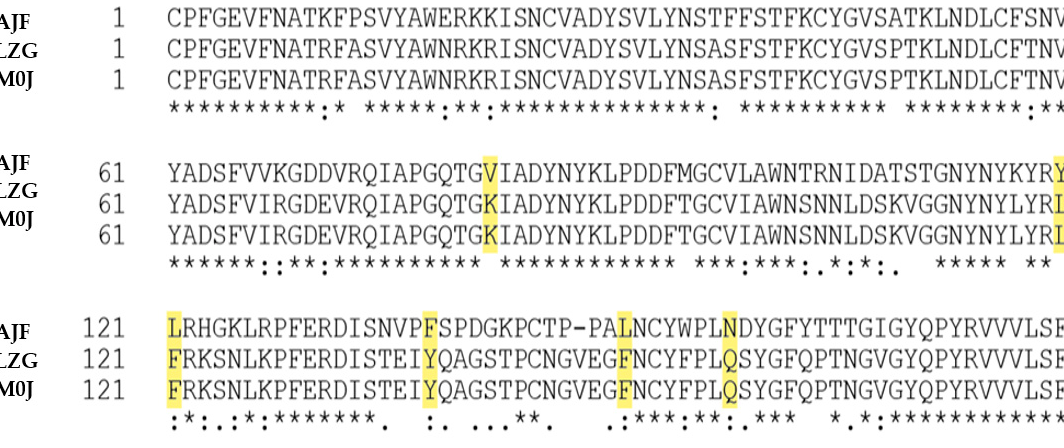
The most prominent substitutions are highlighted in yellow. 2AJF stands for PDB ID of the receptor